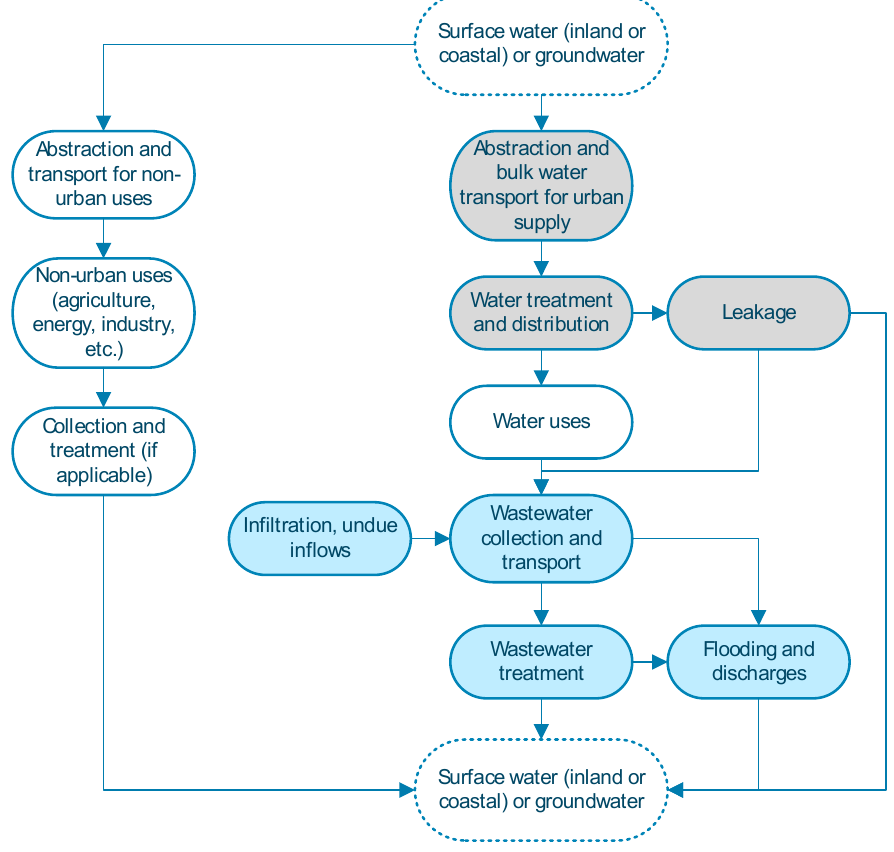
Figure 1. Water sector processes managed by service providers in urban areas (shaded boxes). The water supply and wastewater sectors, represented with grey and blue shaded boxes in Figure 1, respectively, have a significant energy footprint. These sectors